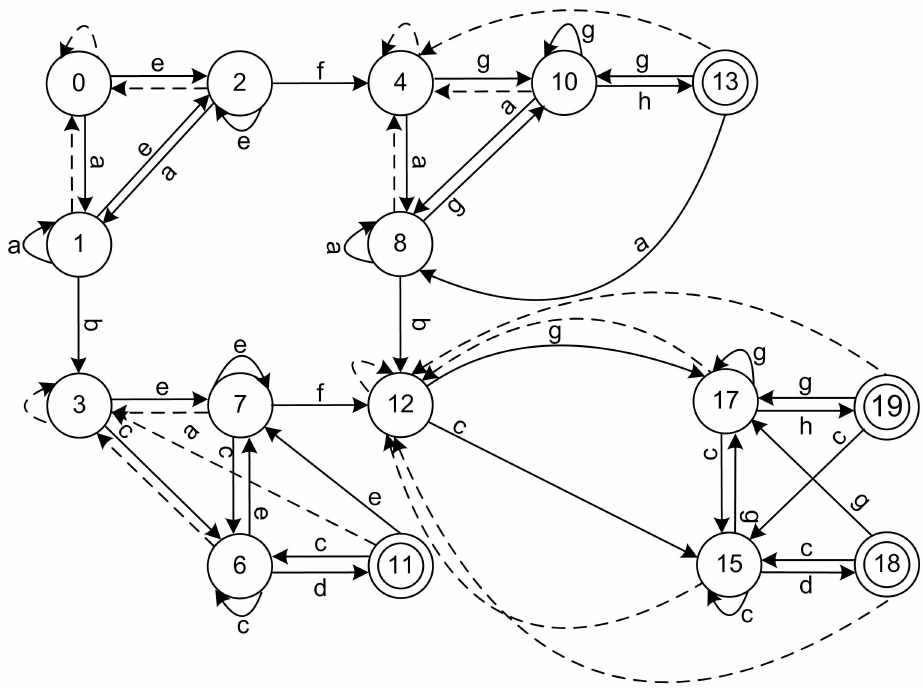
Fig 7. Minimal DFA using the algorithm based on backward depth information for regular expressions (ab. * cd, ef. * gh). The states 4, 9, 12 and 14 are disappearedfor the reason that these have been merged into different states, respectively. The minimal DFA is equivalent with originalDFA functionally, and is isomorphicwith the final block within Table